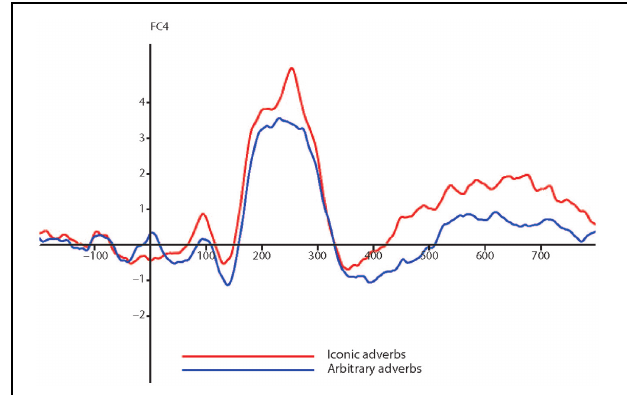
FIGURE 1 | Event-related potential (ERPs) in response to iconic and arbitrary adverbs.